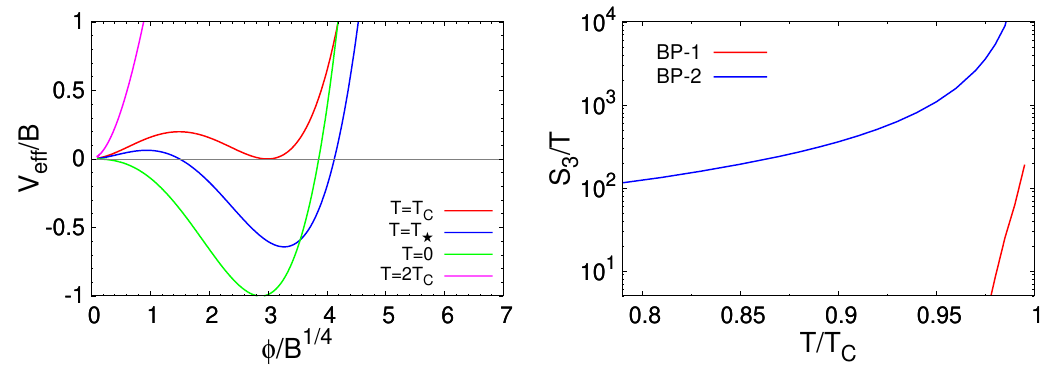
Figure 1 . Left-panel: the effective potential V eff ( φ, T ) for BP-2 : λ = 0 . 16 , A = 0 . 1 , B = (43 . 5 keV) 4 , C = 6 . 23 keV , D = 0 . 45 . In this case, T c = 0 . 93 B 1 / 4 and T ? = 0 . 79 B 1 / 4 . Right-panel: S 3 /T for benchmark points BP-1 and BP-2 in table